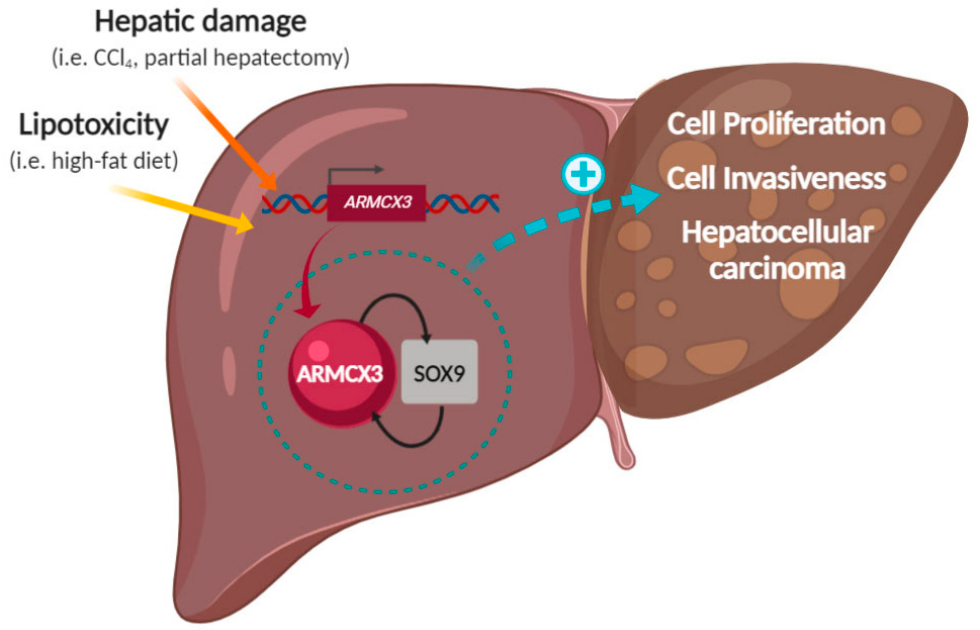
Figure 8. Schematic representation of the role of hepatic ARMCX3, in interaction with SOX9, in eliciting proliferative signals and hepatocarcinogenesis in response to lipotoxicity and hepatic damaging signals.